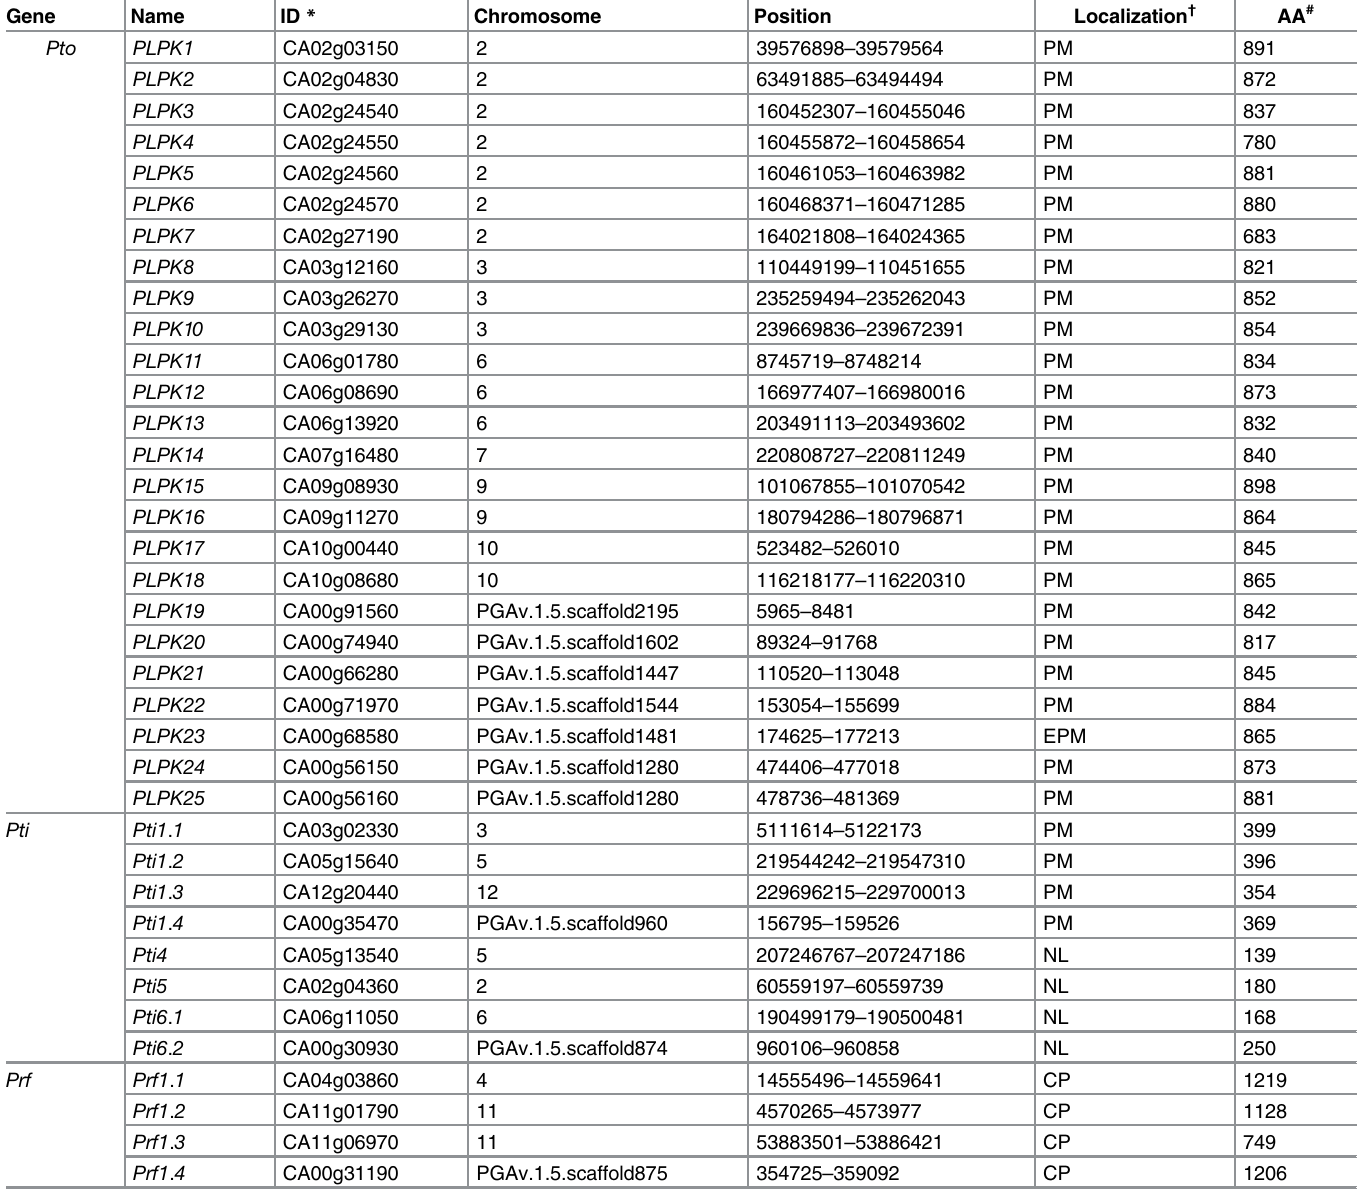
Table 1. Pto-like genes in pepper and other pepper genes related to Pto